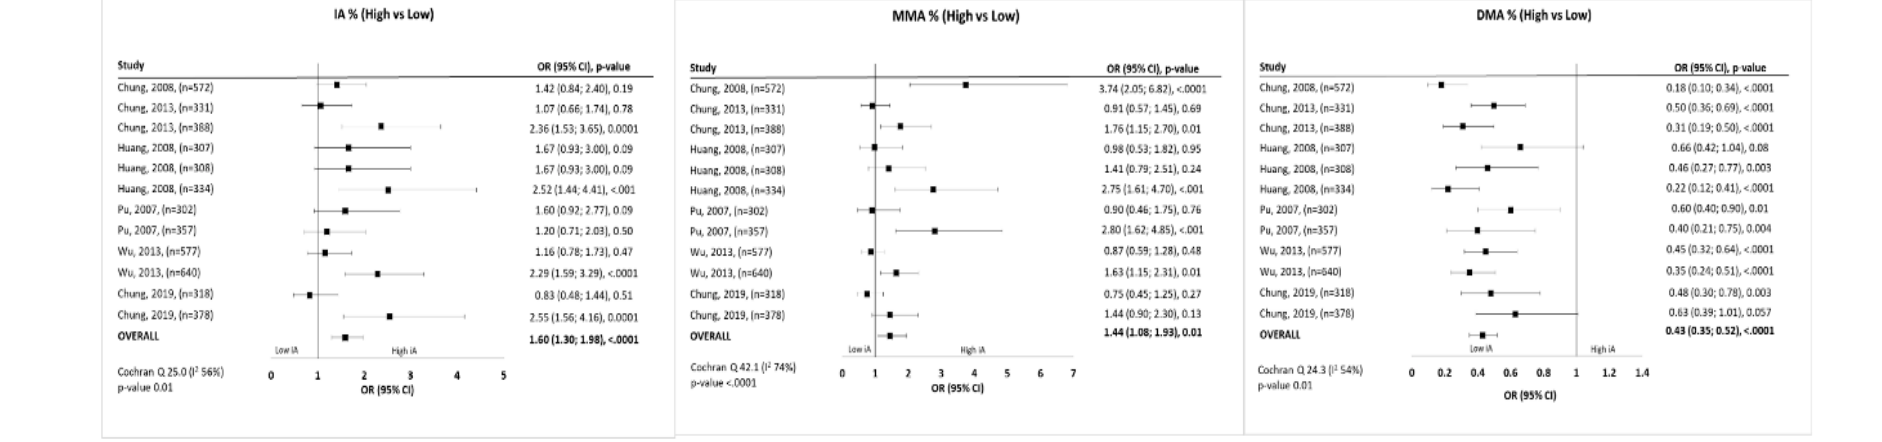
Figure 3. Forest-plot of association between arsenic metabolites distribution and urothelial cancer.